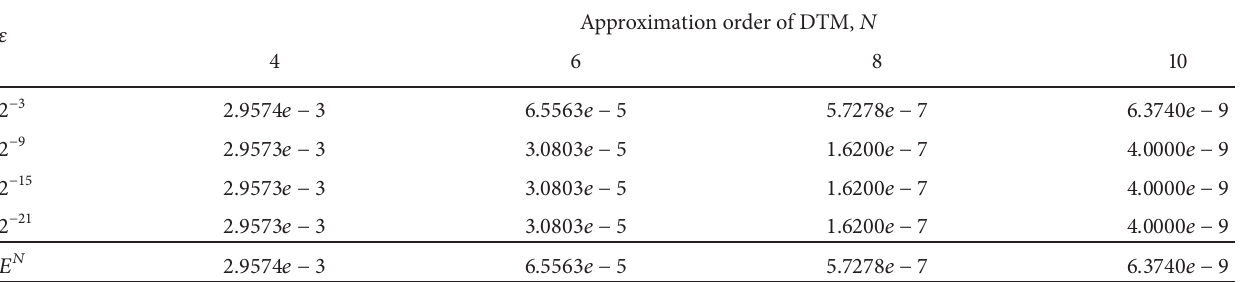
Table 2: Maximum pointwise errors 𝐸 𝑁 𝜀 and 𝐸 𝑁 for the solution 𝑦 1, ap of Example